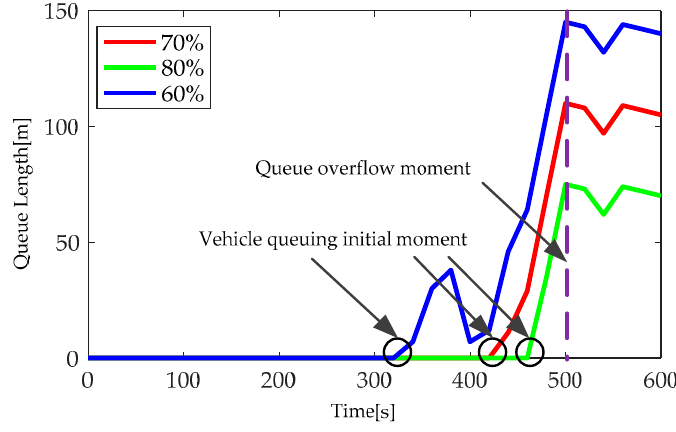
Figure 8. Different overflow limit point simulation results.